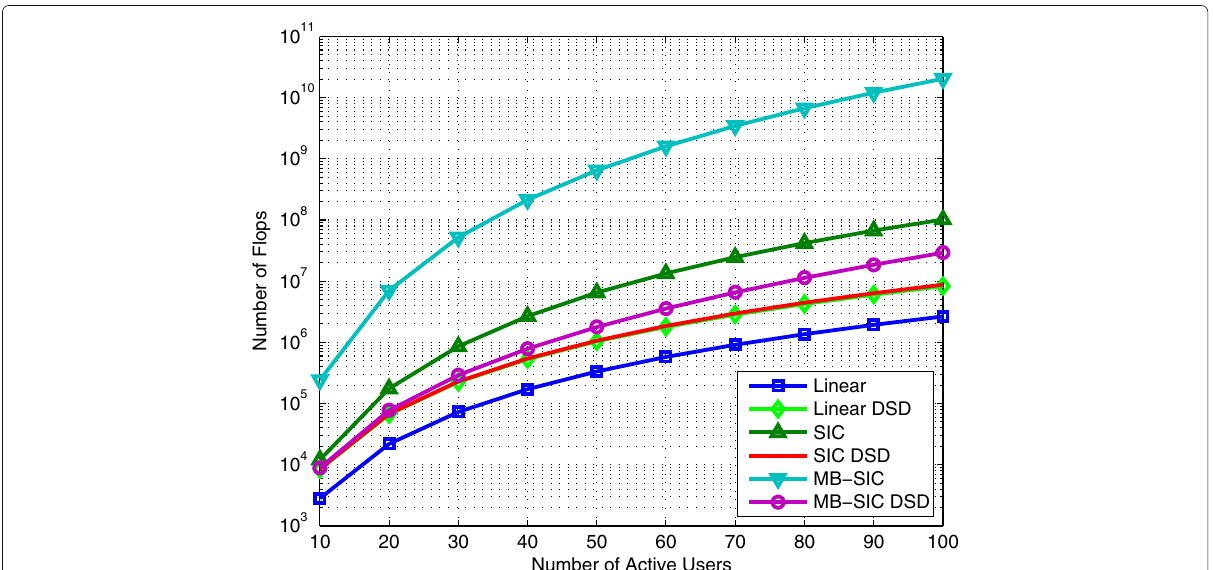
= 2 antennas per user, N k , n